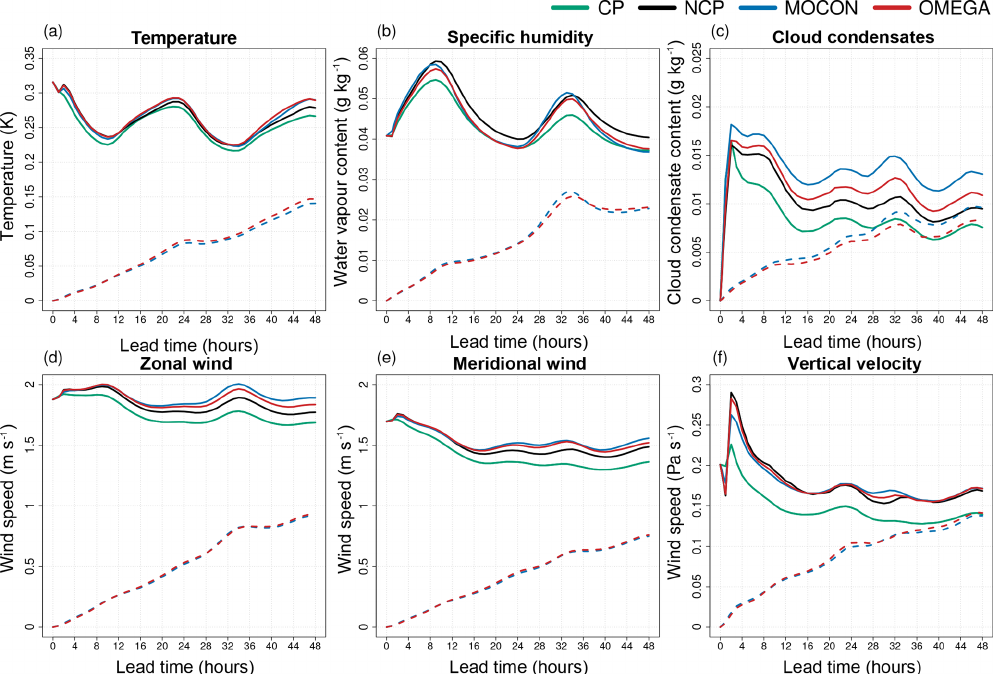
Figure 13. Ensemble spread of the MOCON (blue) and OMEGA (red) ensemble with (full lines) and without (dashed lines) IC and LBC perturbations together with the NCP (black) and CP (green) ensemble spread (created only by IC and LCB perturbations) at 250hPa. Spread is calculated for temperature (a) , specific humidity (b) , cloud condensates (c) , zonal (d) and meridional (e) wind, and vertical velocity (f) .